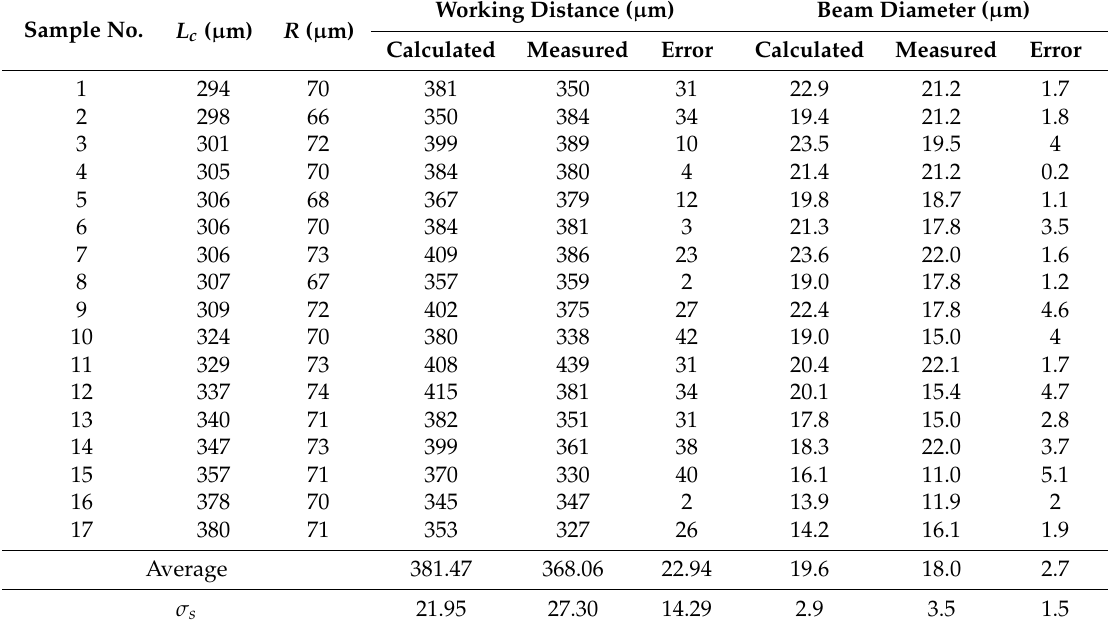
Table 1. Calculated and measured working distances and beam diameters of a total of 17 fabricated LOFs. Working Distance ( µ m) Beam Diameter ( µ m) Sample No. L c ( µ m) R ( µ m) Calculated Measured Error Calculated Measured